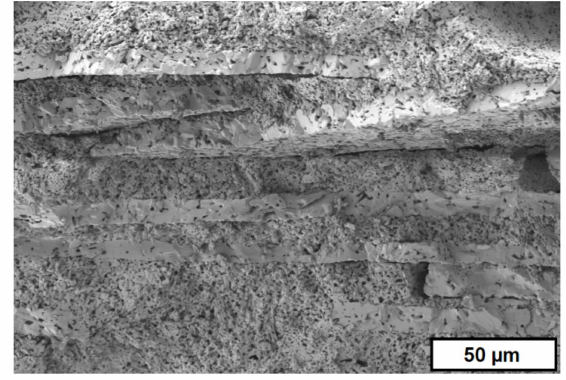
Figure 4. Crack surface of CaAl–Al 2 O 3 component after a bending test (manufactured by group “Shaping”,